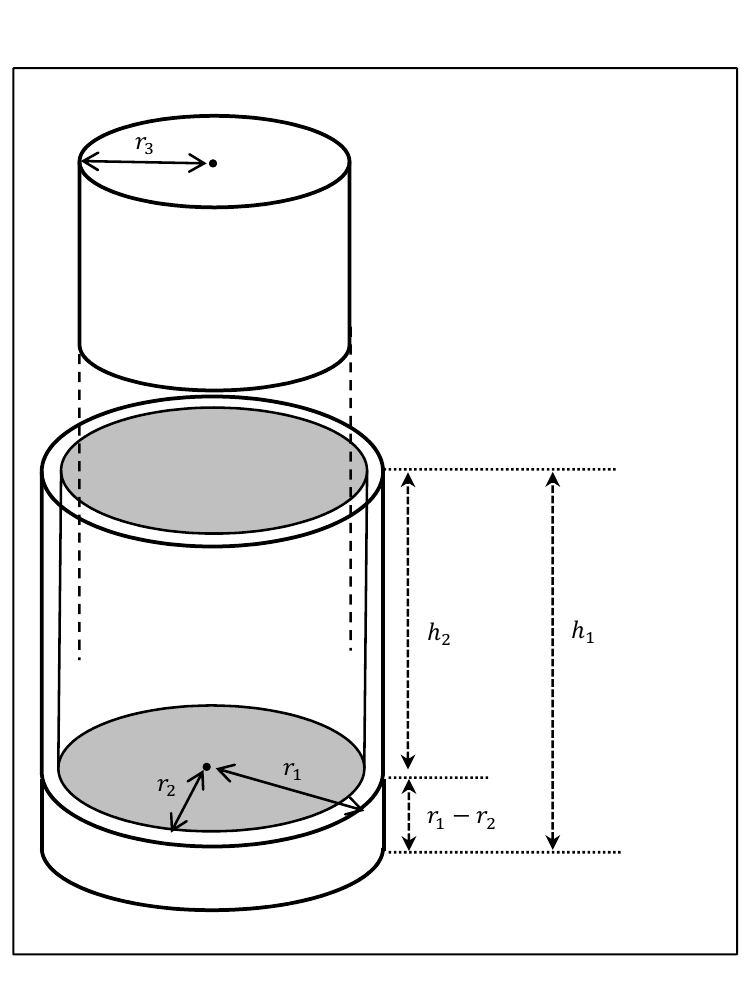
Figure 3. The dimensions of the lower and upper blocks.